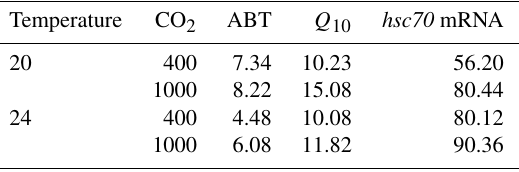
Table 2. Coefficients of variation (%) of Arrhenius breakpoint tem- perature (ABT), temperature coefficients ( Q 10 ) , and hsc70 mRNA expression at 38 ◦ C 1 , 2 .